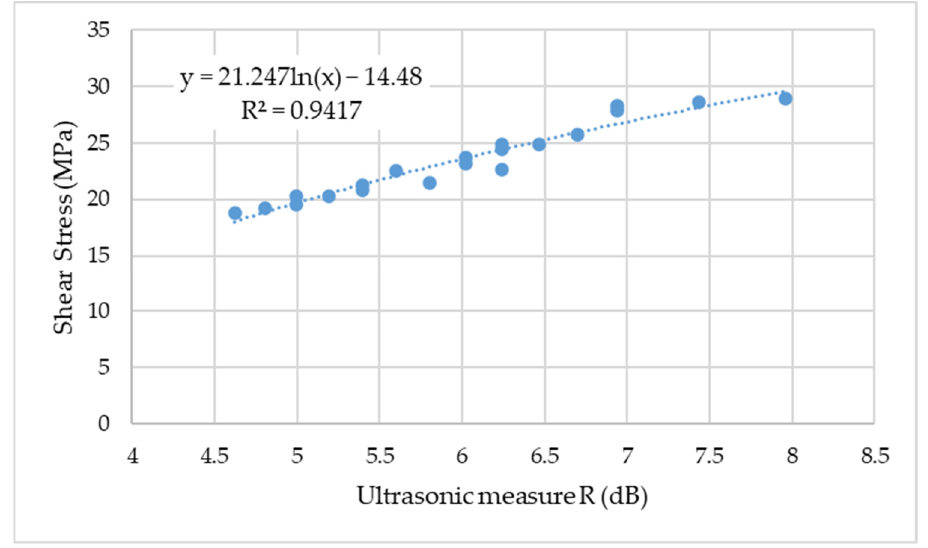
Figure 13. Correlation test results.